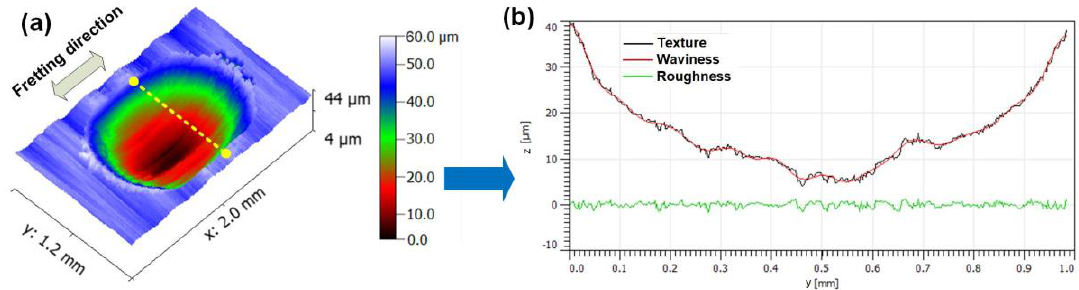
Figure 3. Roughness measurements: ( a ) cross-section scanning of fretting wear scar and ( b ) measuring of worn surface roughness (WSR).